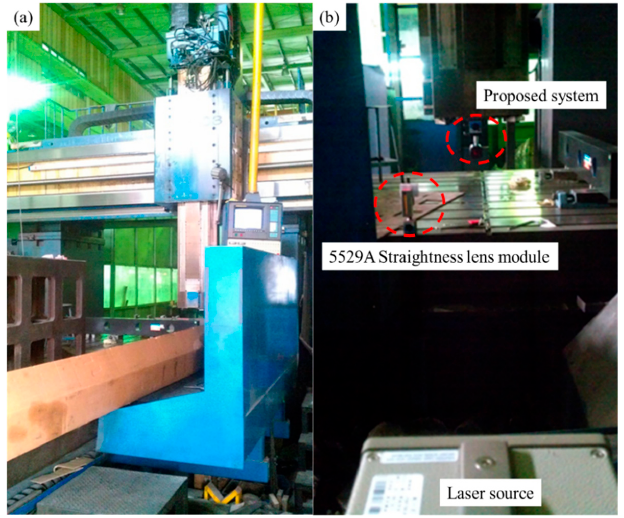
Figure 21. Case 2 straightness error measurement setup on double column machine tool, ( a ) the double column machine tool and ( b ) the setup of 5529A laser interferometer straightness module and proposed system. proposed Table 7. Case 2 straightness error measurement results.